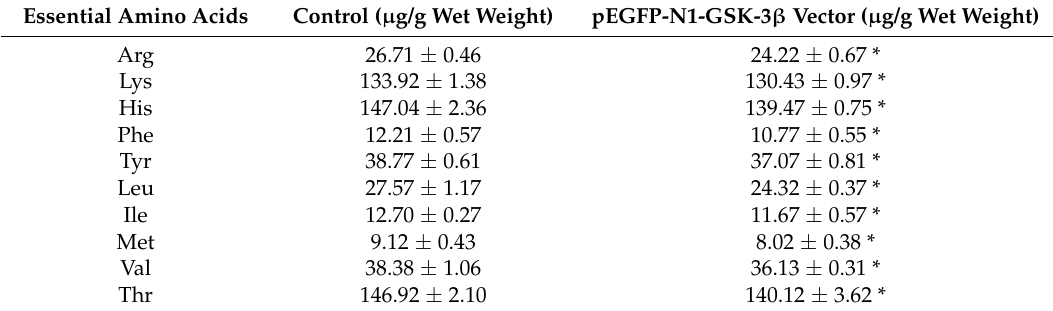
Table 3. Effect of the pEGFP-N1-GSK-3 β vector on the content of free amino acids in the muscle of